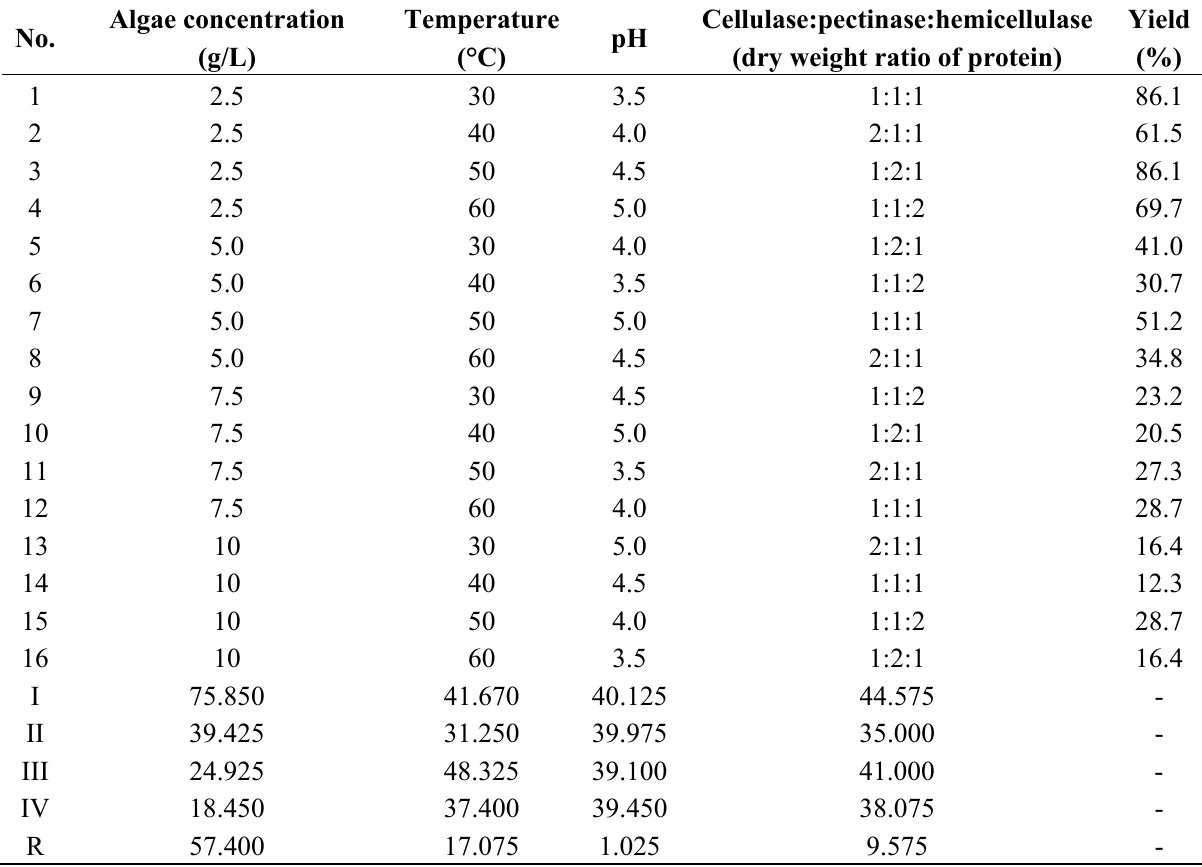
Table 4. Results of orthogonal tests on the yield of oil extraction from Scenedesmus sp. G4 by enzyme-assisted hydrolysis.